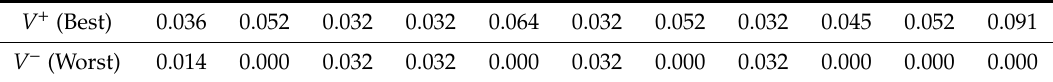
Table A4. Full calculations of the LCC criteria TOPSIS.